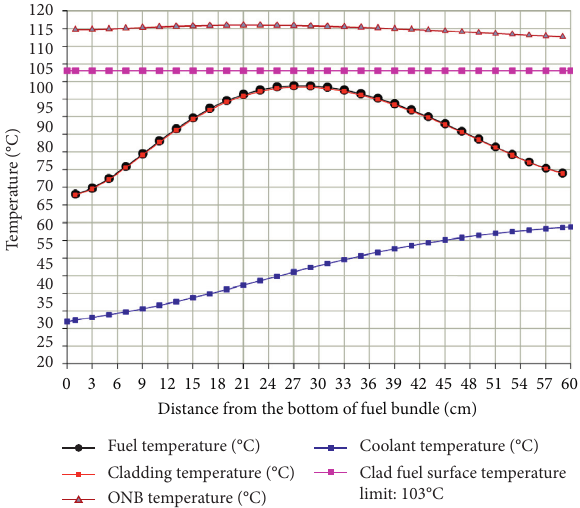
Figure 9: Calculated temperatures at nominal power with global hot channel factors (with systematic uncertainties).